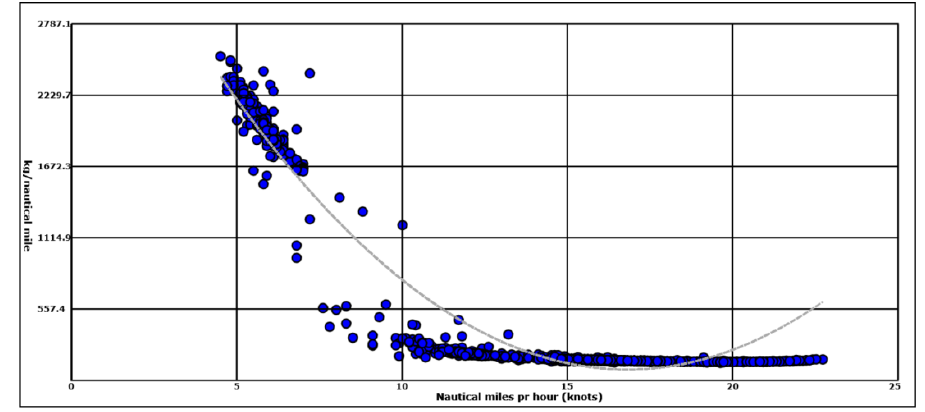
Figure 13. Load factor (actual power over installed power) profile for Norwegian Star , May 2016, using IMO formula. Blue points are estimated load factors for different speed values, gray line is fitted second-degree polynomial trend-line.